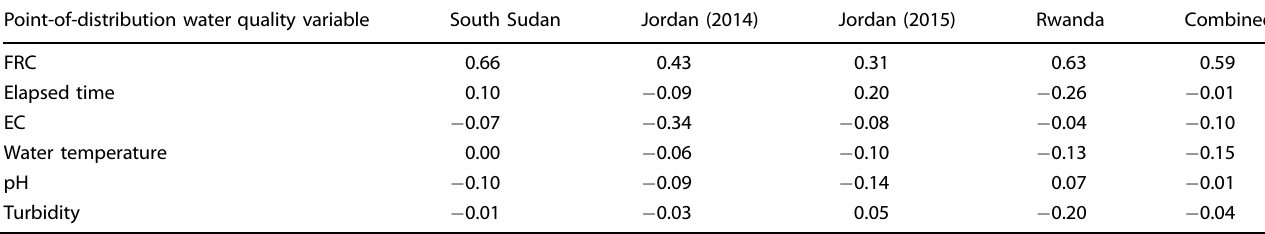
Fig. 6 Rwanda observations and post-processed forecasts of point-of-consumption FRC. The observations and forecasts are shown against a point-of-distribution FRC, b elapsed time, c point-of-distribution EC, d point-of-distribution water temperature, e point-of-distribution pH, f point-of-distribution turbidity. IV2 forecasts tend to be much more dispersed, leading to better overall capture, especially of observations with point-of-consumption FRC below 0.2 mg/L. Table 2. Partial correlation analysis results between water quality variables and point-of-consumption